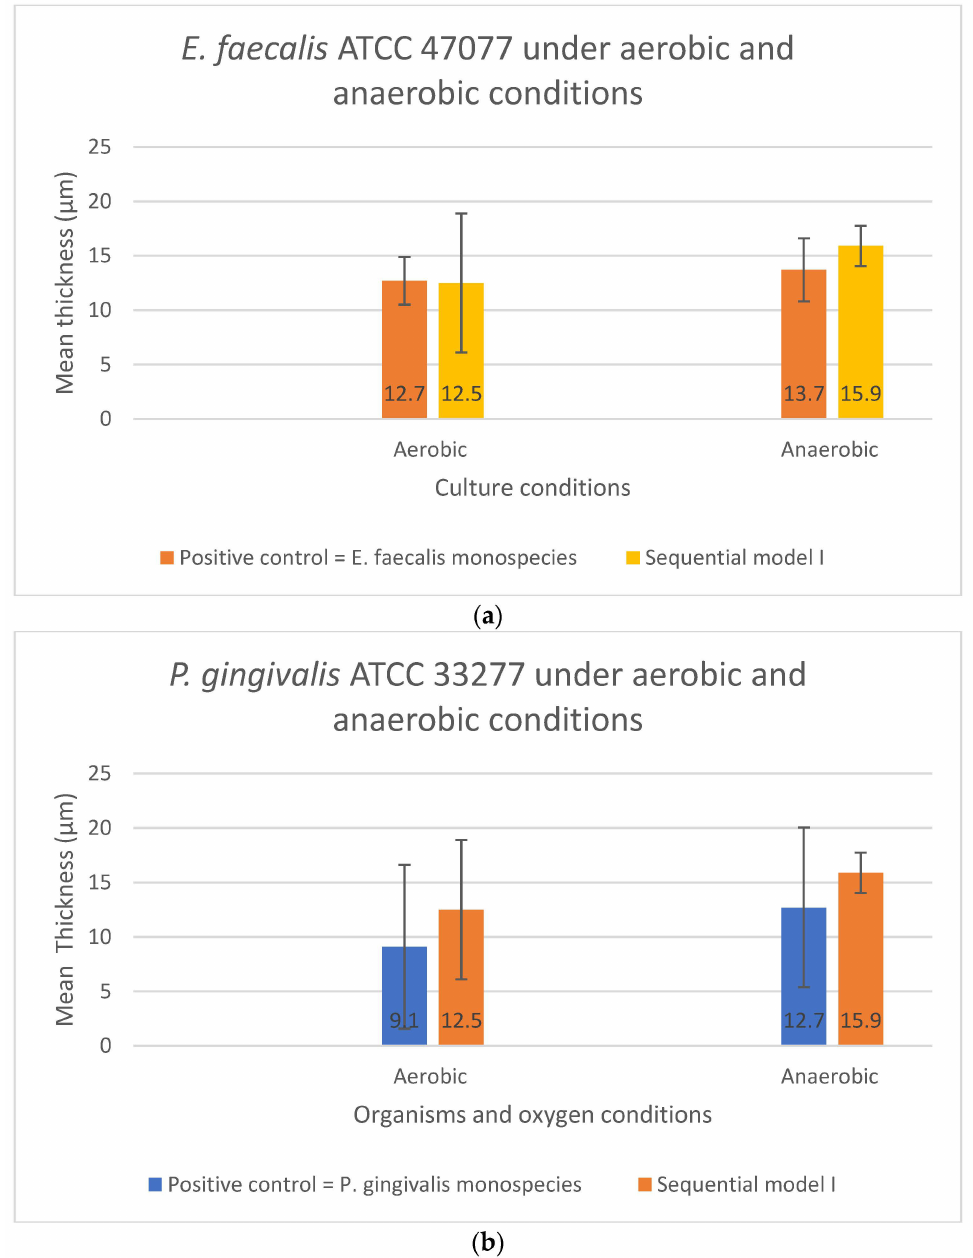
Figure 4. The biofilm thickness of ( a ) E. faecalis and ( b ) P. gingivalis cultured independently under aerobic and anaerobic conditions based on Sequential model I and mono-culture models. Data represent the mean and standard